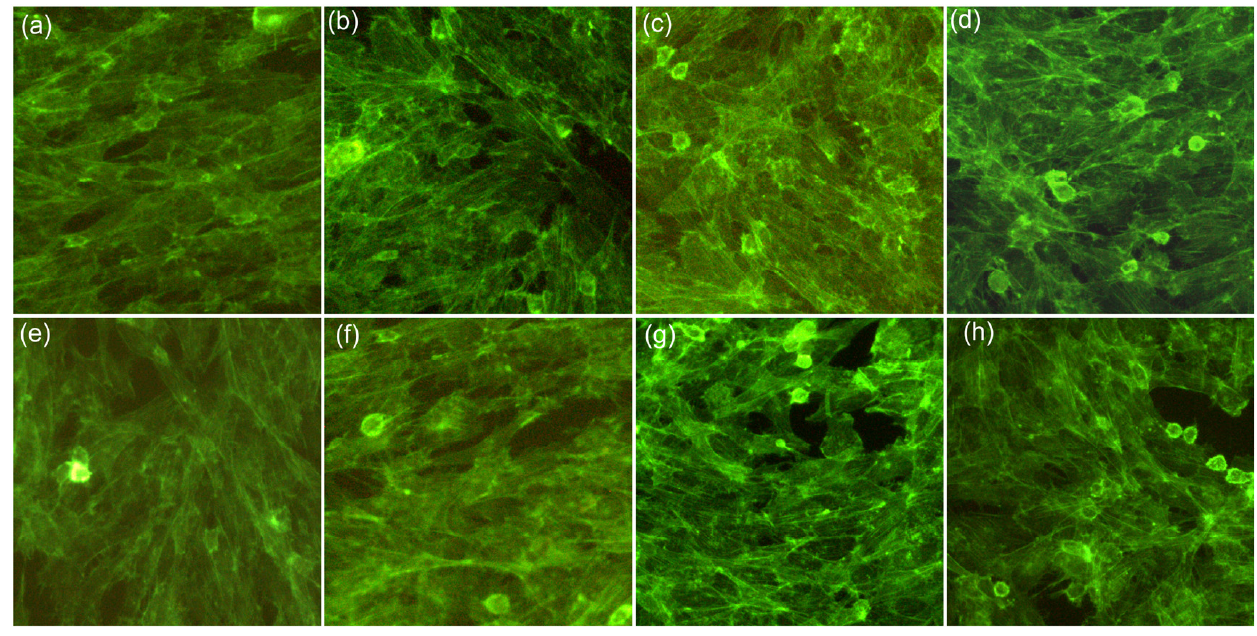
Figure 8. The morphology of hFOB 1.19 cells incubated with ZnHApC ( b and f ), ZnHApC-7D ( c and g ), and ZnHApC-14D ( d and h ) for 24 h ( a – d ) and 72 h ( e – h ) relative to an untreated hFOB 1.19 cell culture used as control ( a and e ).